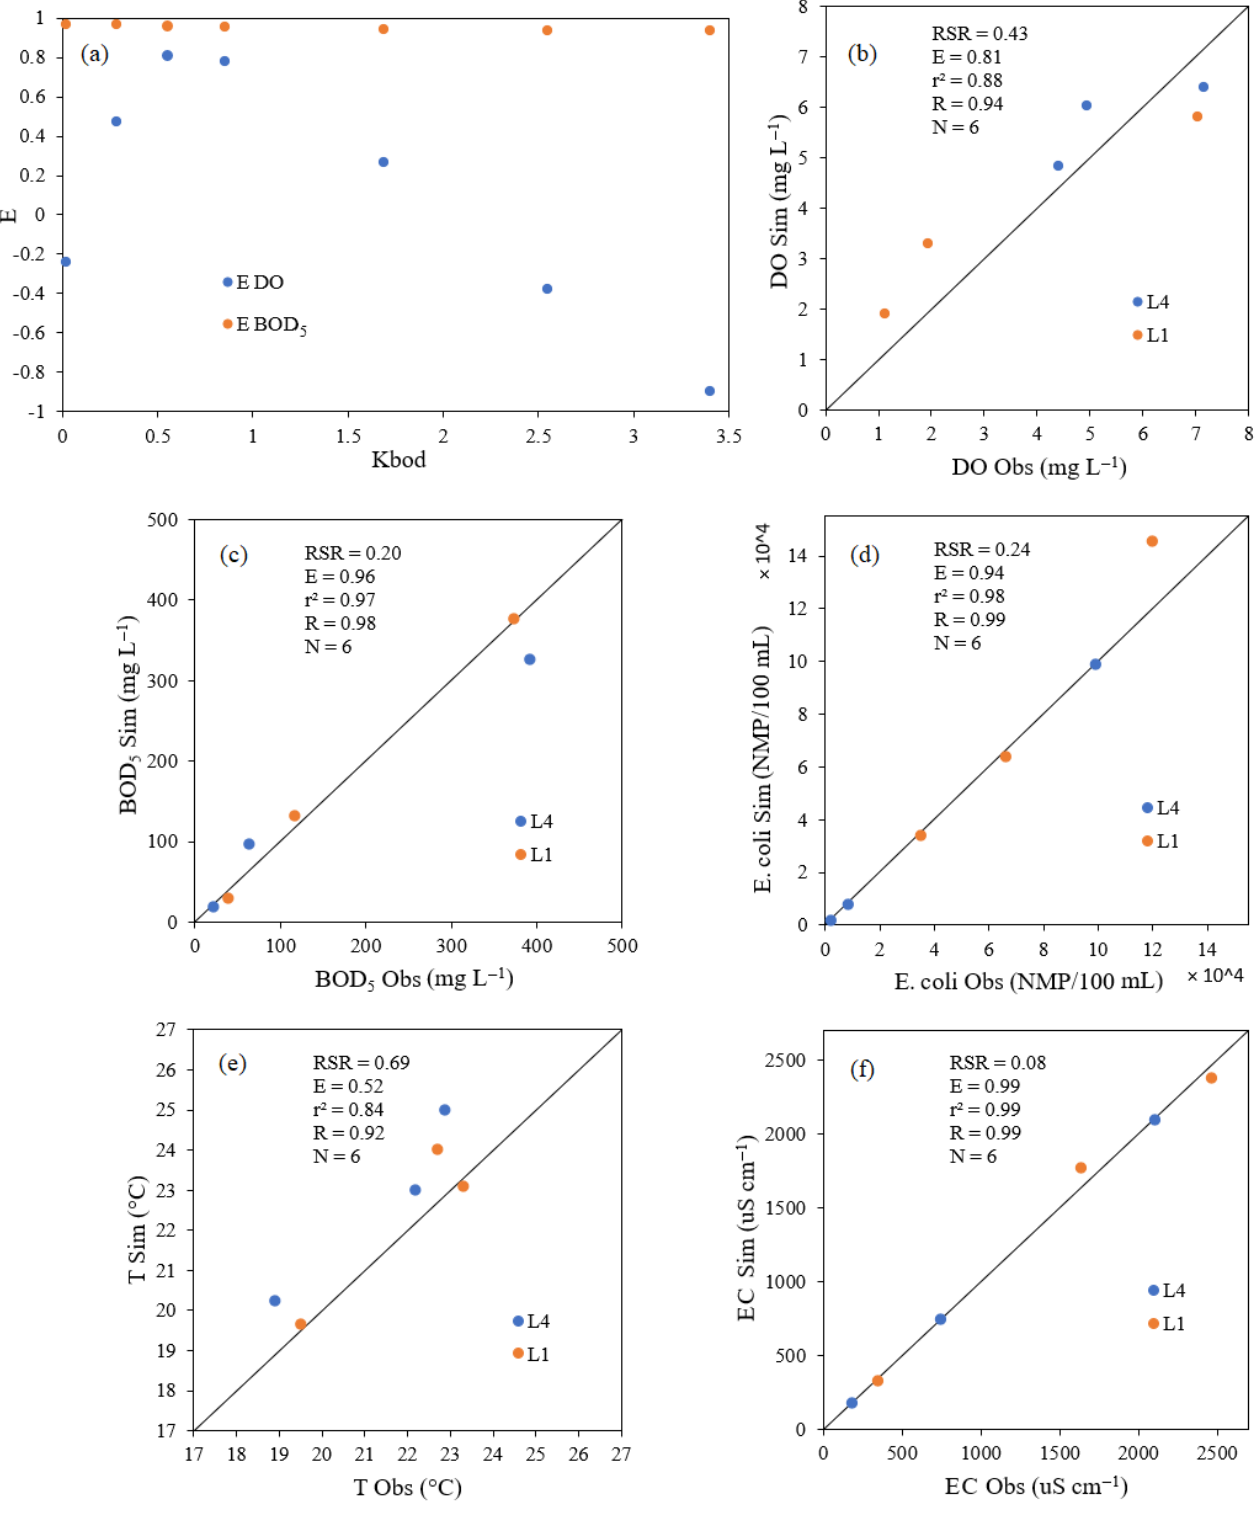
Figure 4. ( a ) Range of values of the E index due to changes in the parameter K bod in March, May, and July. Comparison between observed and simulated values according to: ( b ) dissolved oxygen, ( c ) BOD 5 , ( d ) E. coli , ( e ) temperature, and ( f ) electrical conductivity.